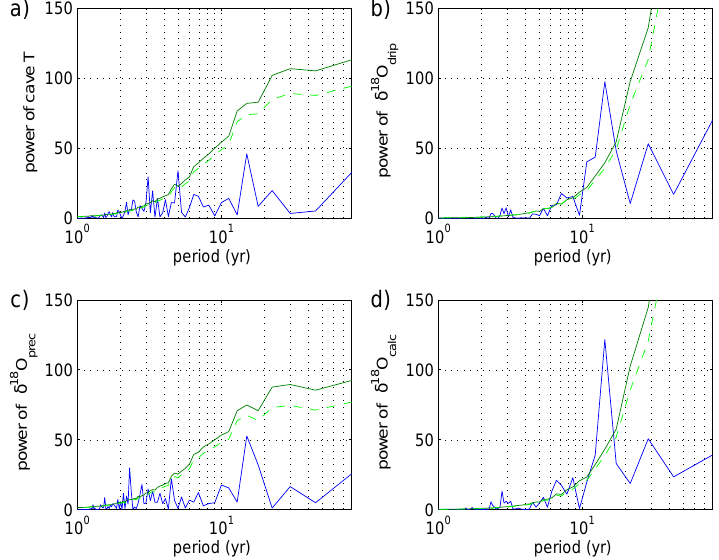
Fig. 4. Power spectra of the annual mean (a) cave temperature, (b) δ 18 O drip , (c) δ 18 O precip , (d) δ 18 O calc at the Bunker Cave. The green lines denote the 95% (90%) highest spectrum of 1000 AR(1) processes with the same autocorrelation.